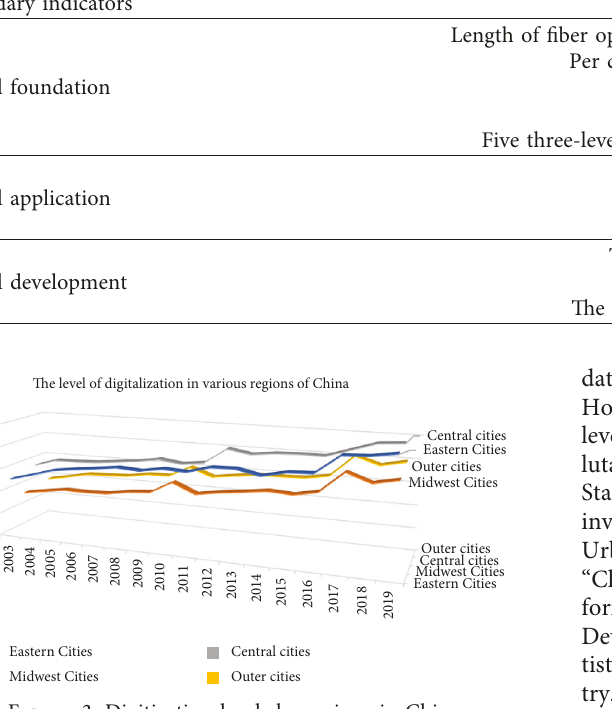
Figure 3: Digitization levels by regions in